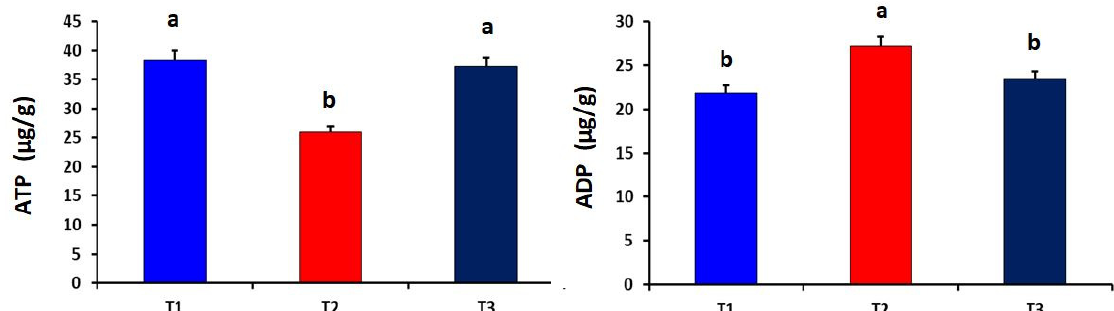
Figure 2. Effect of dietary curcumin supplementation on the levels of adenosine triphosphate (ATP) and adenosine diphosphate (ADP) in liver tissues of heat-stressed broiler chickens ( p = 0.001 and 0.011, respectively). a,b Values within a row with different superscripts differ significantly.